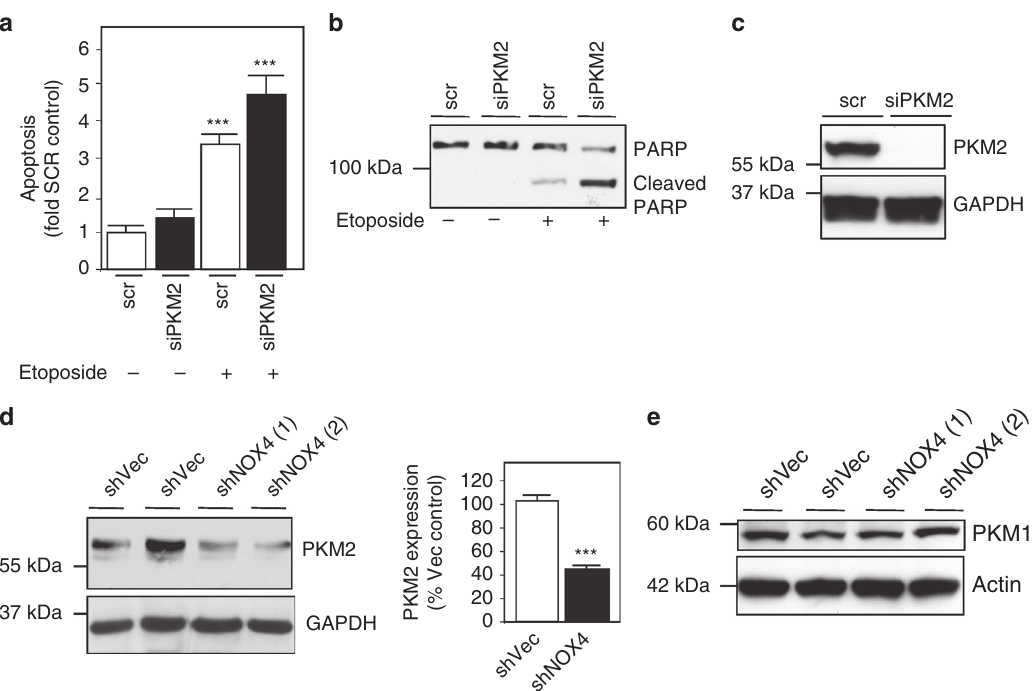
Fig. 5 PKM2 is a novel mediator of RCC drug resistance. a RCC 786-O cells were transfected with scrambled RNA (scr) or small inhibitory RNA (siRNA) speci fi c for PKM2 (siPKM2) using Amaxa. After 48 h, the transfected cells were incubated (+) with or without ( − ) etoposide (20 µ M) for 14 h. Apoptosis was analyzed by Annexin V staining and fl ow cytometry. The results are presented from at least three independent experiments and expressed as the means where ± S.E.M. *** p < 0.001 compared to non-treated scr or siPKM2 control (scr). b In parallel to a , cell lysates were prepared and PARP cleavage was examined by western blot analysis. c Successful PKM2 downregulation was veri fi ed by western blot analysis. GAPDH was used as a loading control. d (Left panel) PKM2 expression was examined by western blot in shVector or shNOX4 RCC 786-O stable cell lines. GAPDH was used as a loading control. (Right panel) Quantitation of d using one-way ANOVA with Tukey ’ s post hoc test where ± S.E.M. *** p < 0.001 is compared to shVector control. e PKM1 expression was examined in parallel to d . Actin was used as a loading